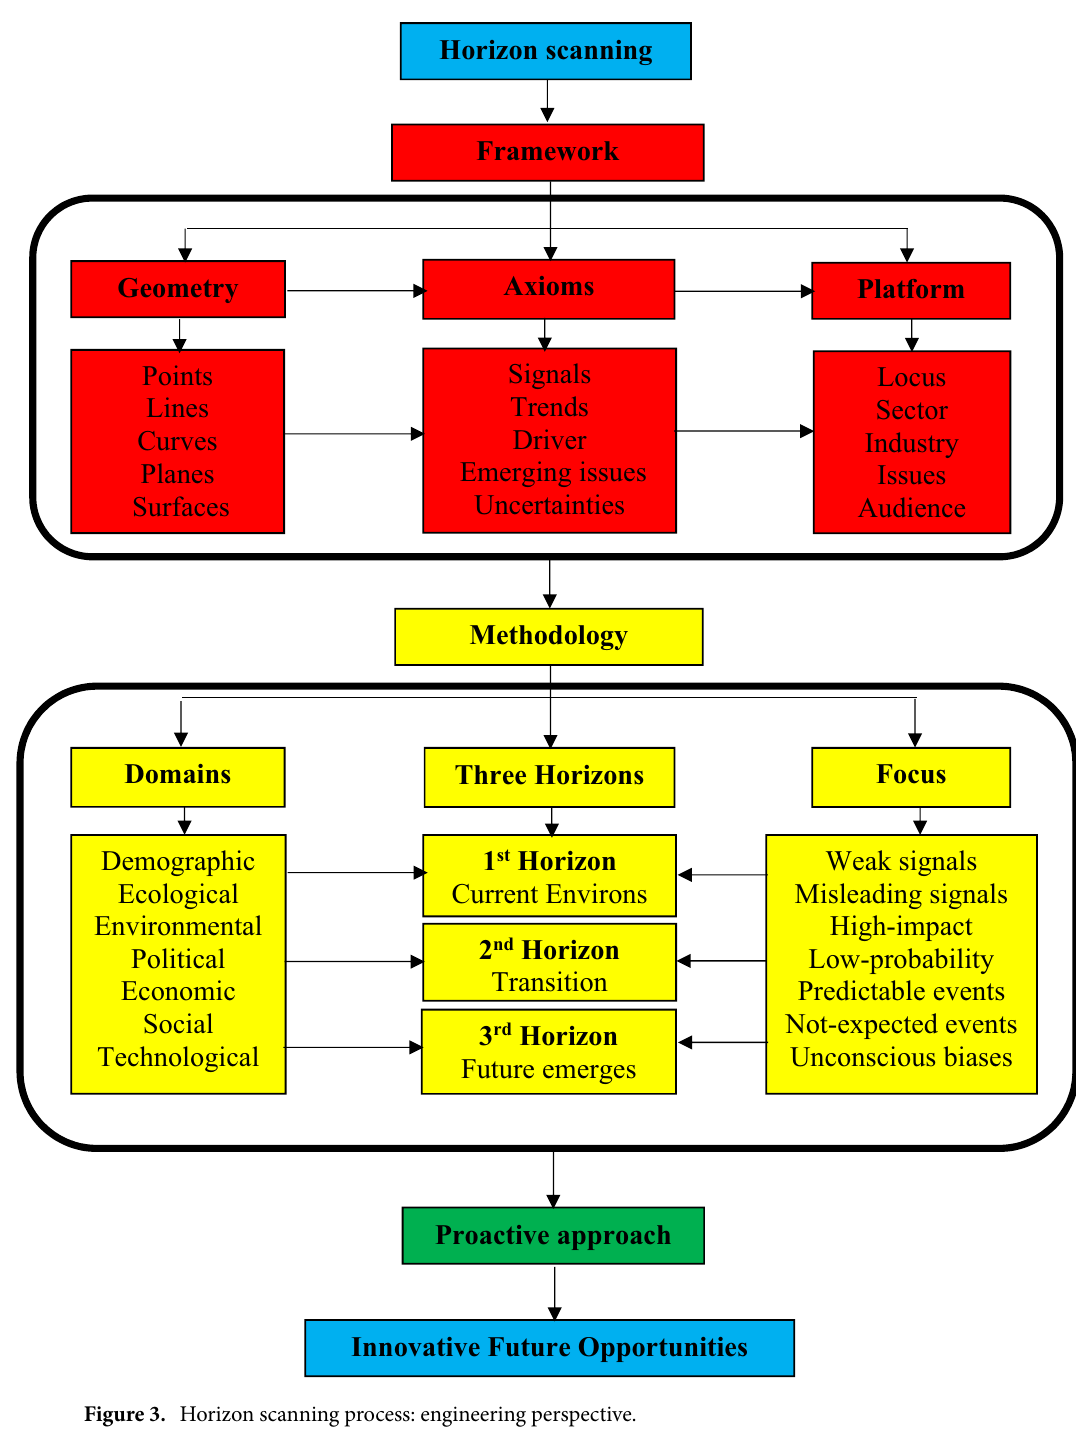
Figure 3. Horizon scanning process: engineering